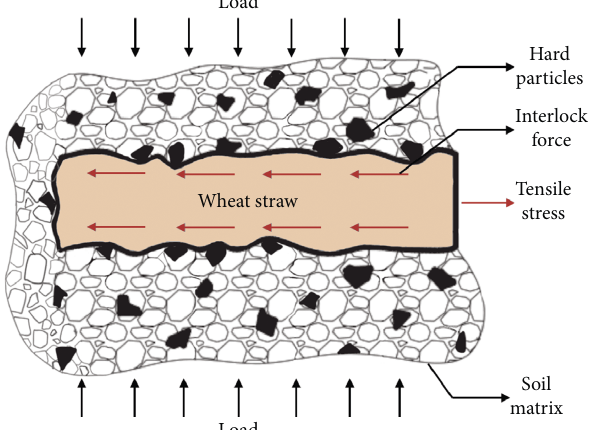
Figure 6: Schematic diagram of interfacial interaction between wheat straw and